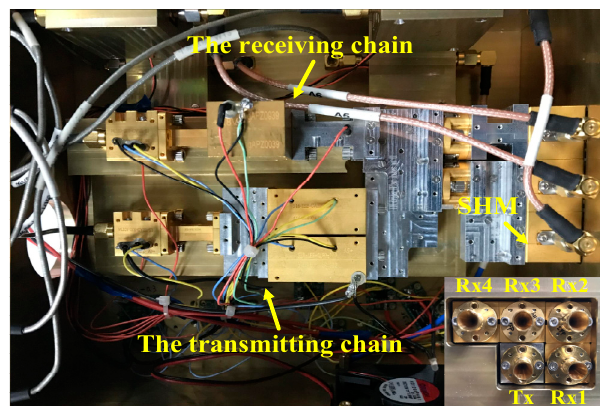
Figure 2. Photograph of front-end setup.